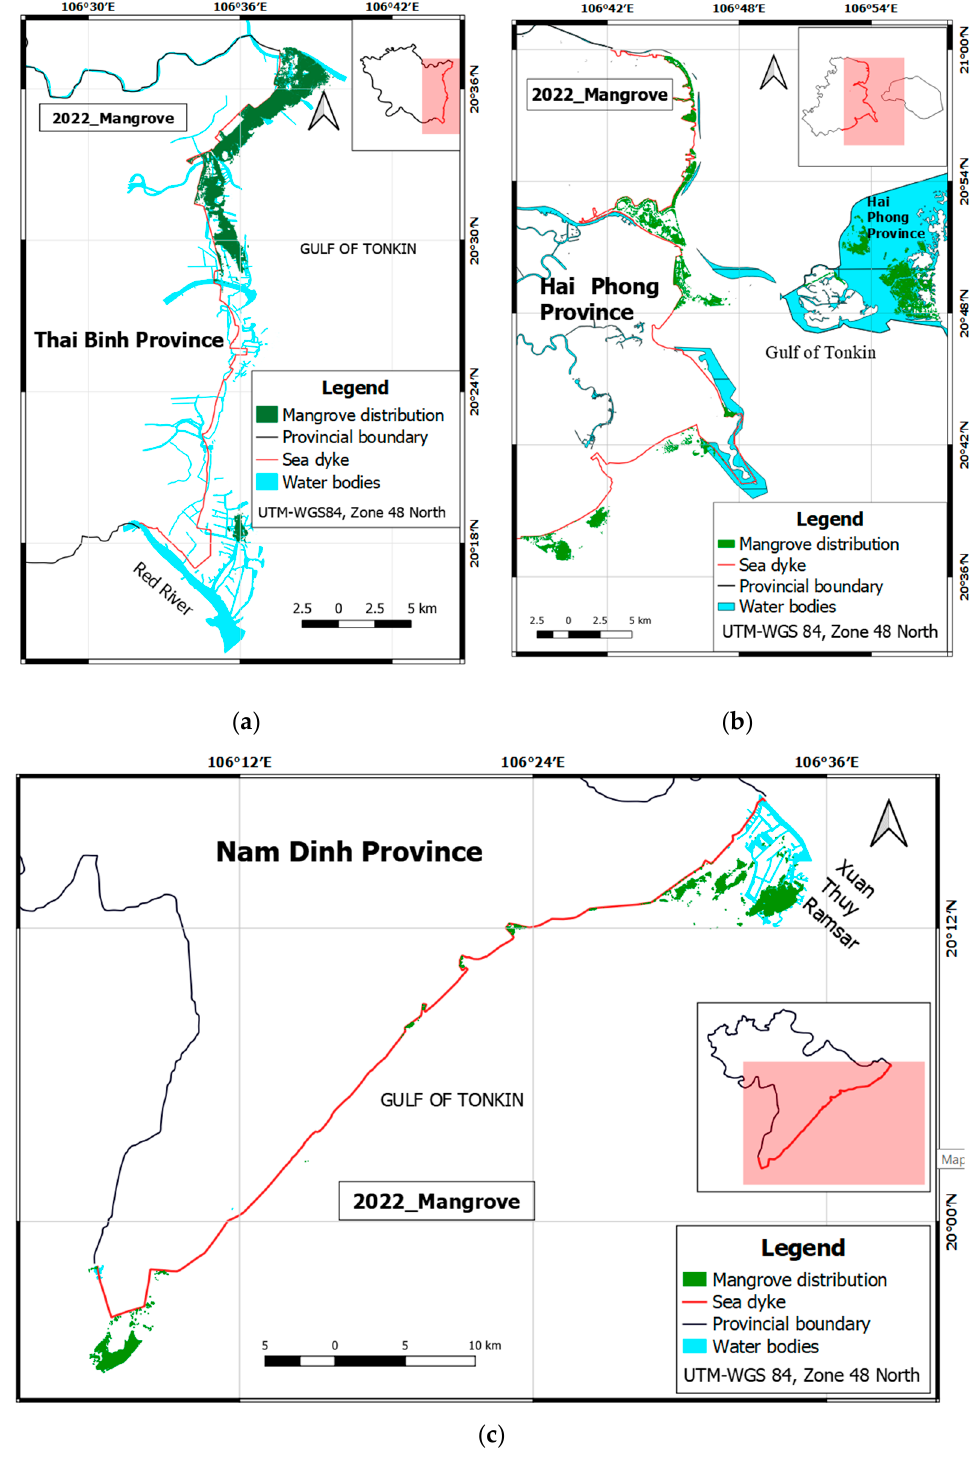
Figure 7. Mangrove maps in the three provinces in 2022 across the RRD, northern Vietnam: ( a ) Thai Binh; ( b ) Hai Phong; ( c ) Nam Dinh.